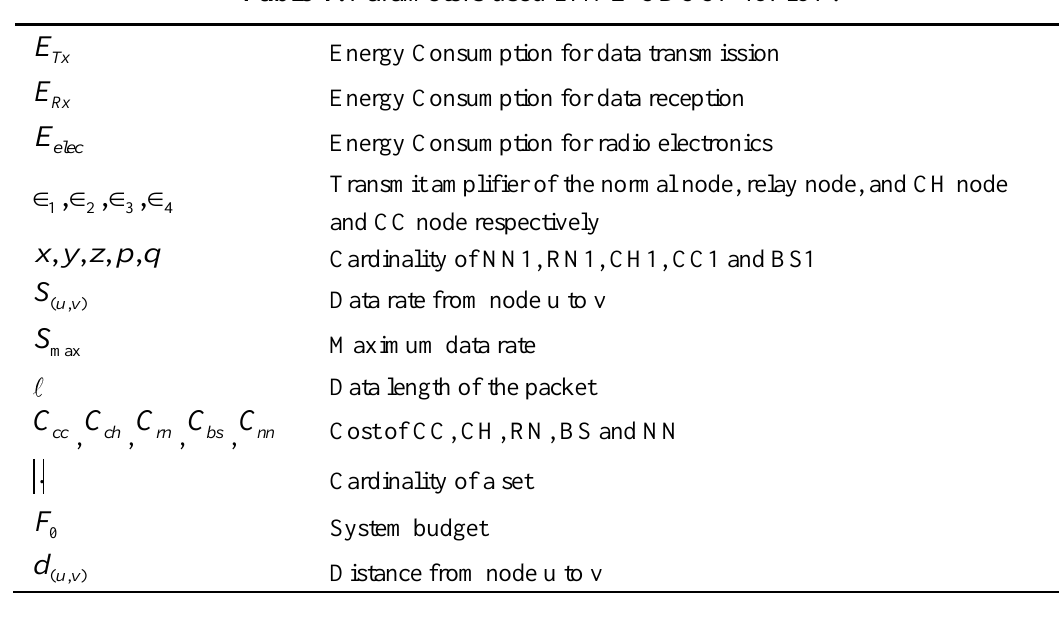
Table 1. Parameters used in ME-CBCCP for